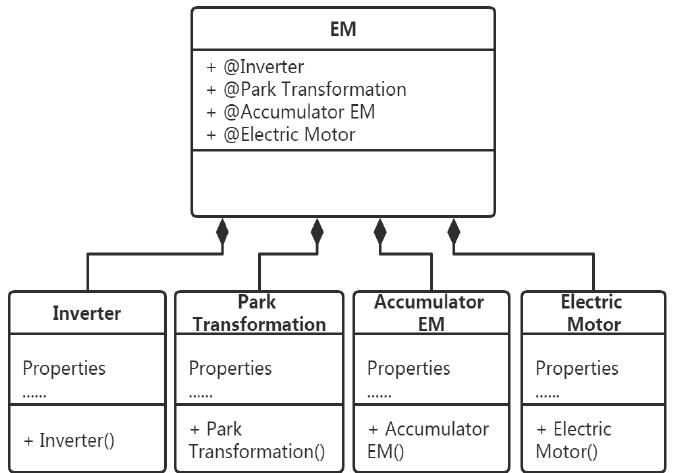
Figure 11. UML of electric motor (EM) OOP model (power source).